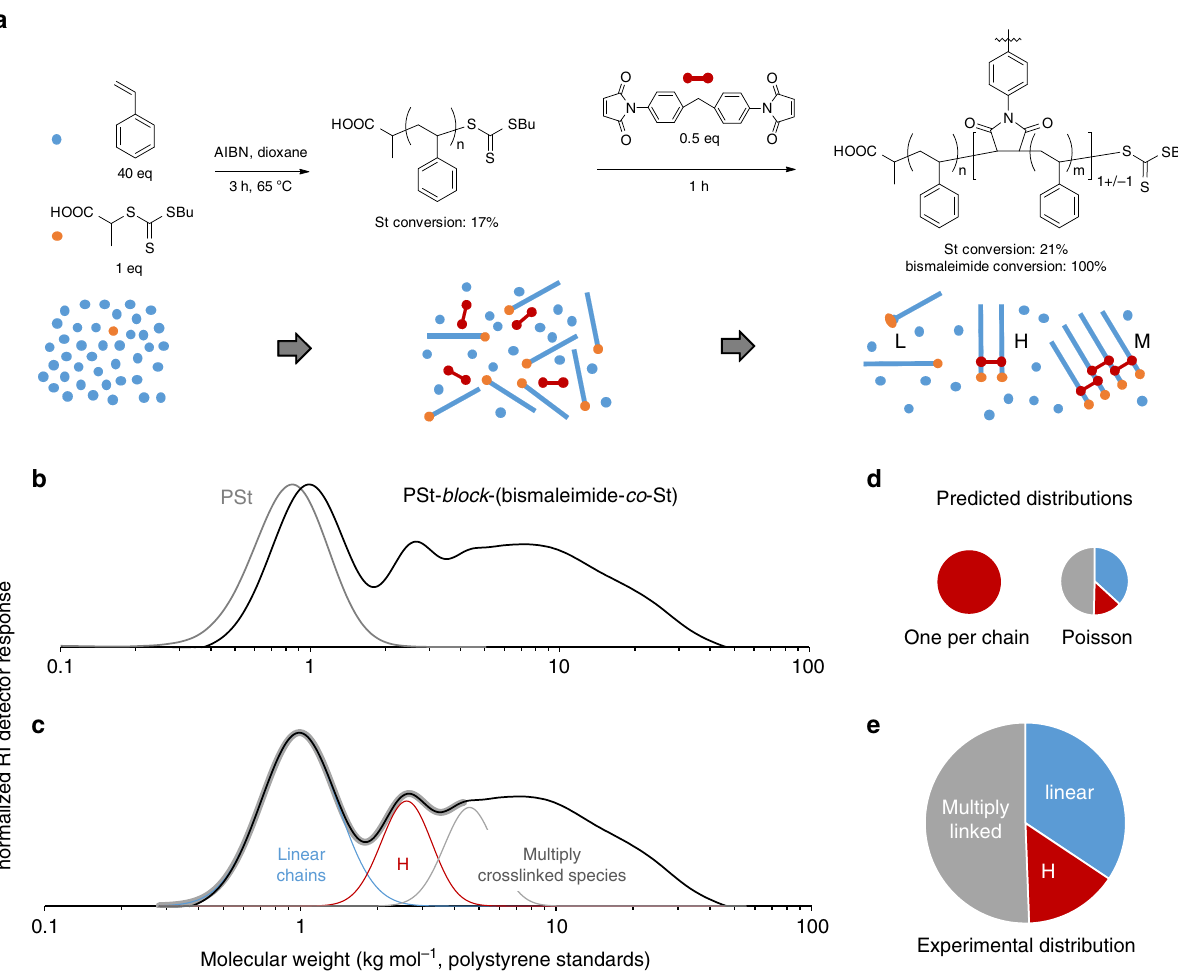
Figure 4 | Addition of bismaleimide to a RAFT polymerization of styrene (St). ( a ) After addition of the bismaleimide (0.5equiv), polymerization was allowed to continue for 1h, during which time the conversion of St increased from 17 to 21% and the bismaleimide was completely consumed. The resulting copolymer contained, on average, 1 maleimide unit per polystyrene chain (with an estimated standard deviation of 1). The distribution of maleimide units resulted in the formation of a mixture of linear chains (L), double chains (H) and multiply linked structures (M). ( b ) Distribution of chain lengths obtained after addition of 0.5equiv. of bismaleimide. Linear chains and multiply linked structures are present in addition to H. The distribution immediately before bismaleimide addition is also shown. Deconvolution ( c ) of the low molar mass portion of the peak using Gaussian components (thick grey line represents best fit) allows estimation of the relative mass fractions of each structure ( e ), which are in good agreement with the predicted distribution assuming that the maleimide content of each chain follows a Poisson distribution ( d